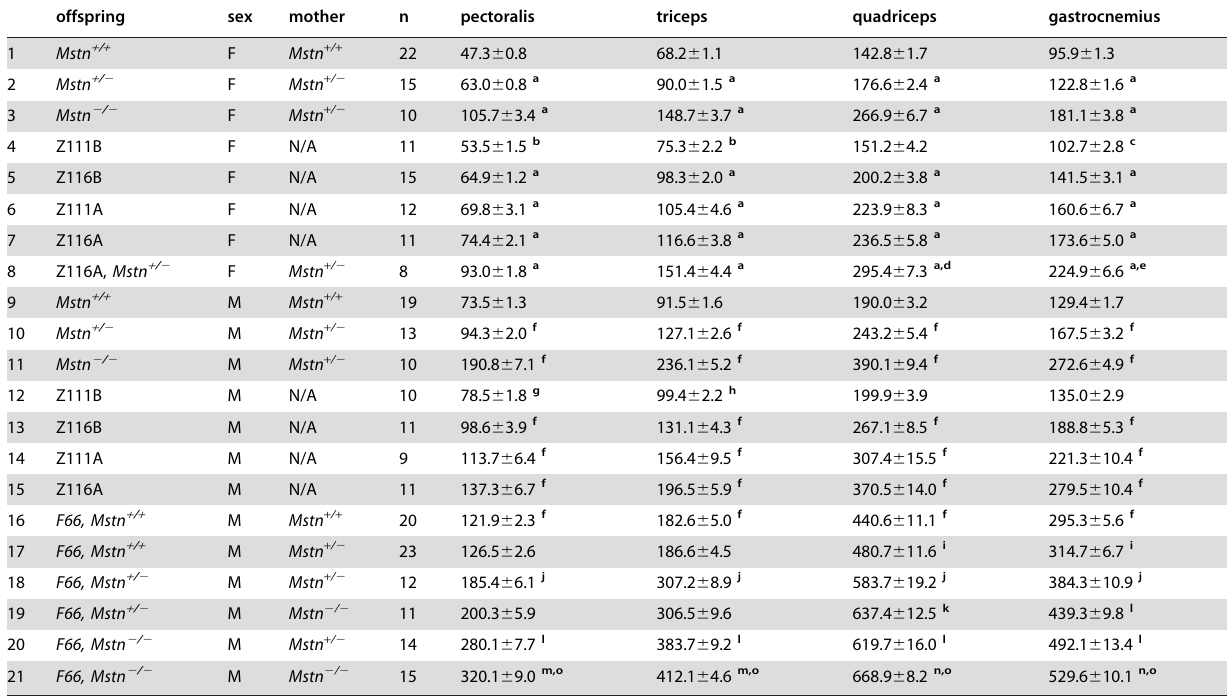
Table 1. Muscle weights (mg) of FLRG (Z) and follistatin (F66) transgenic mice. .. ... .... ... ... .... ... ... .... ... ... .... ... ... .... ... ... .... ... ... .... ... ... .... ... ... .... ... ... .... ... ... .... ... ... .... ... ... .... ... ... .... ... ...